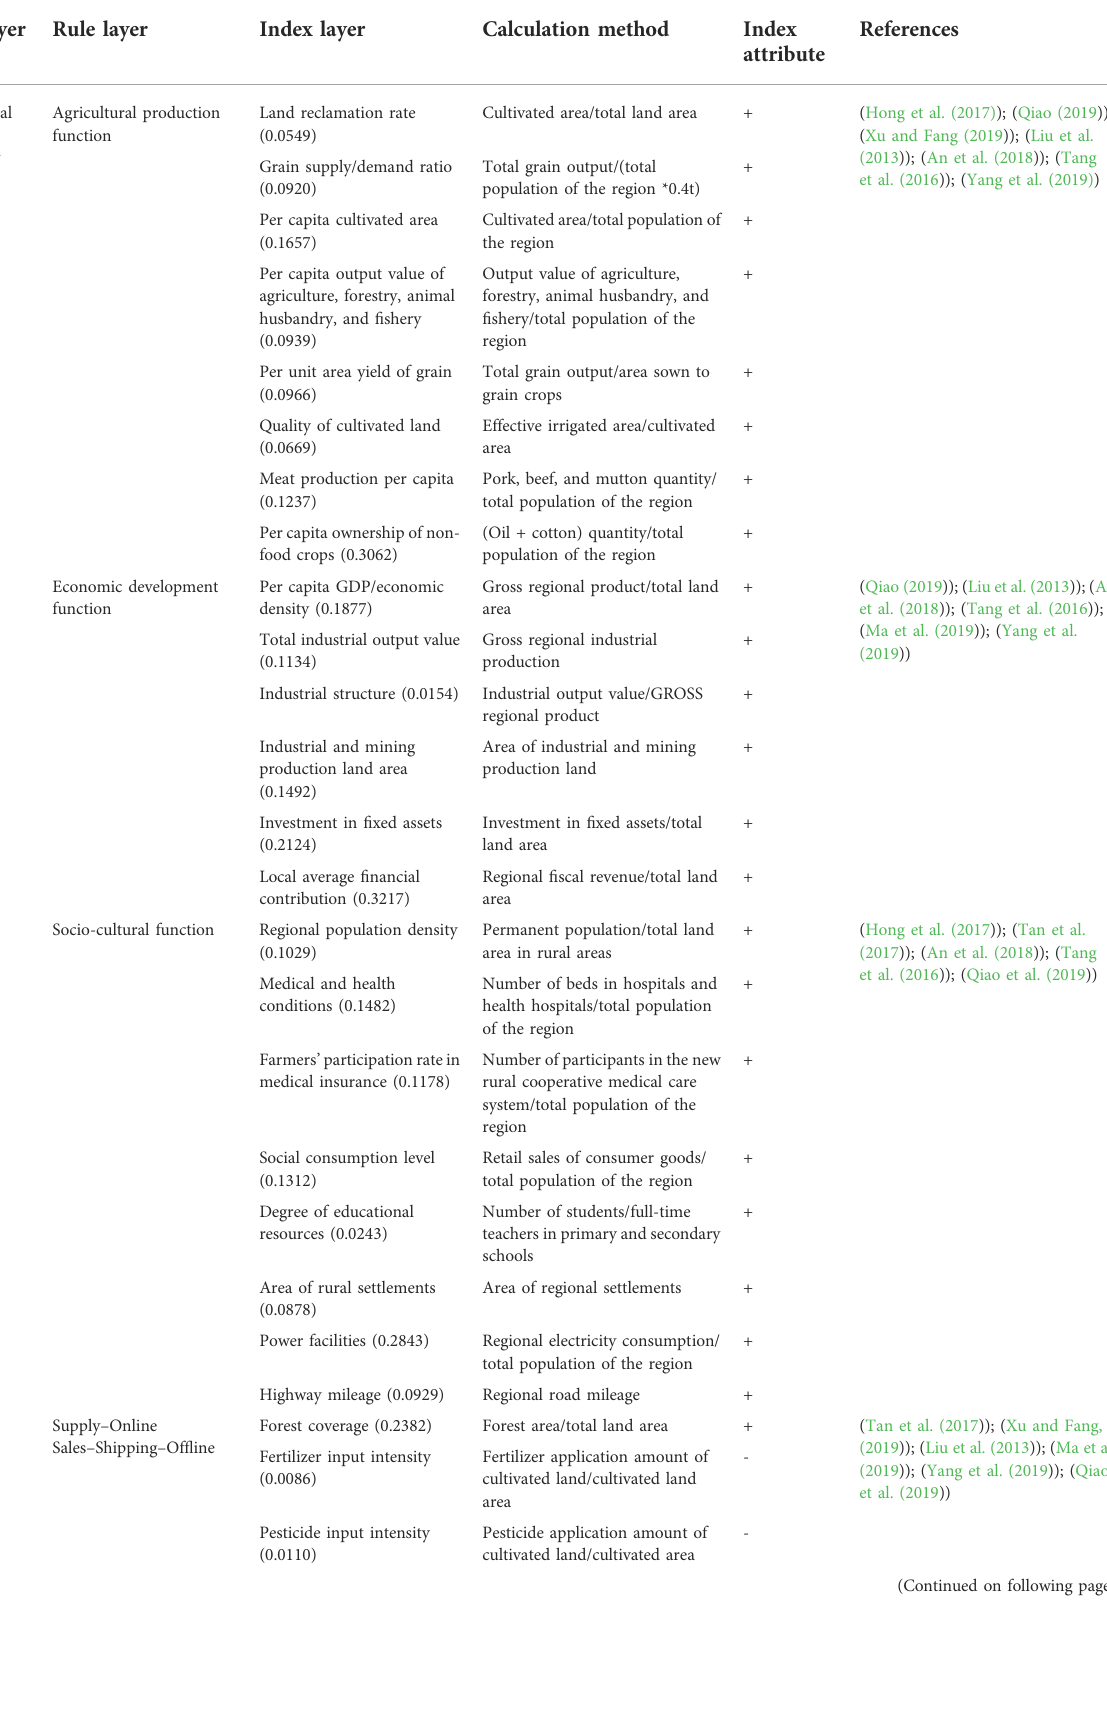
TABLE 1 Index system and weight of rural regional multi-functionality